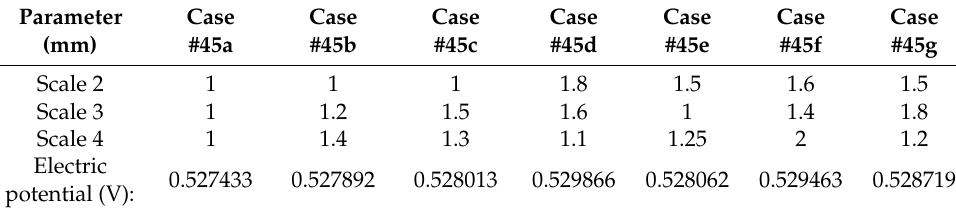
Figure 14. Influence of scaling factors on the electric potential of the cell at current density of 4.0 A·cm − 2 . Table 8. Scaling factors and resulting electric potential at current density of 4.0 A·cm − 2 .